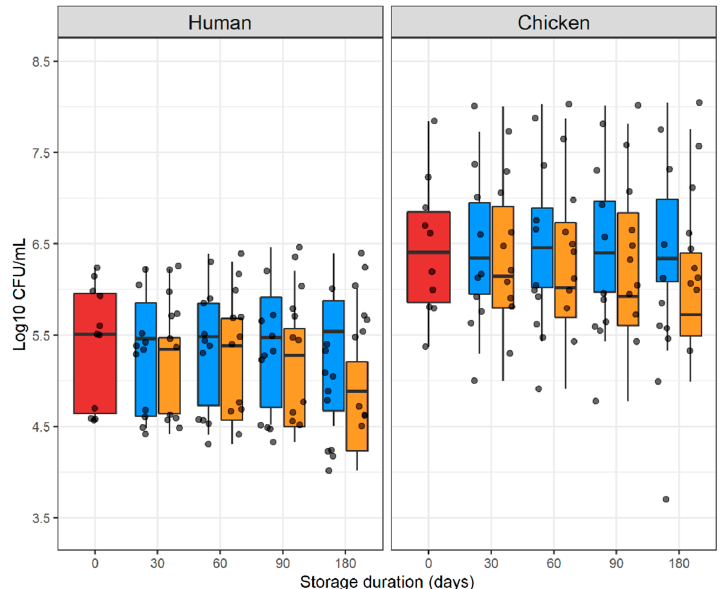
Figure 1. Boxplots displaying median and 25% and 75% quartile of counts of E. coli on ECC plates within 24 h after collection, as well as following storage at − 20 ◦ C and − 80 ◦ C after 1, 2, 3, and 6 months. Red, fresh sample; blue, − 80 ◦ C; orange, − 20 ◦ C. Overall, storage of samples at − 80 ◦ C over time resulted in slightly increased E. coli counts in both human and chicken samples. However, at − 20 ◦ C, there was a considerable reduction in counts over time, which was quantitatively greater for human samples ( − 0.630 per 100 days) compared with chicken samples ( − 0.178 per 100 days, Table